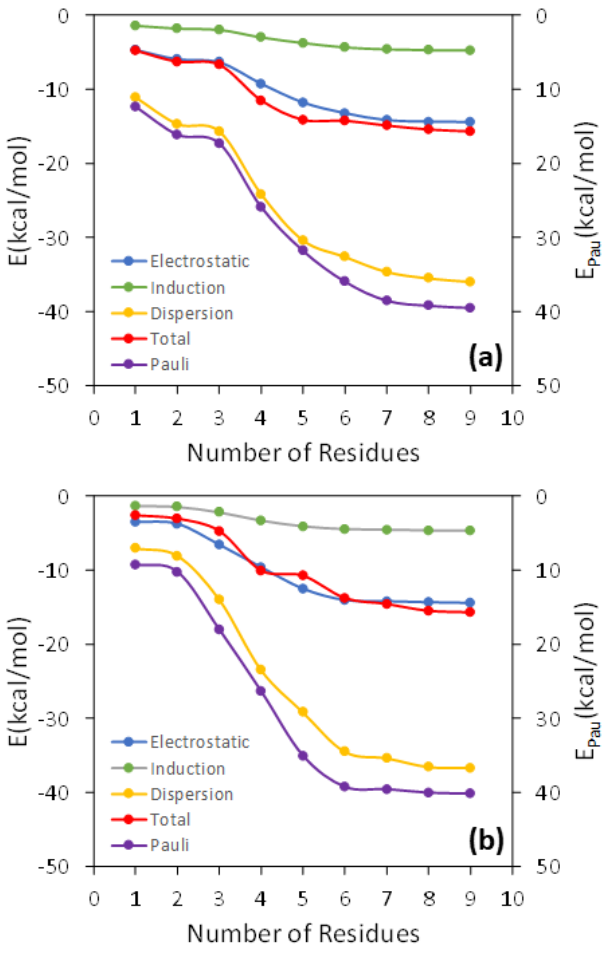
Figure 2. Analysis of the convergence of the interaction energy and its different components as the number of the DOPC molecules increases in the QM region for an arbitrary geometry around the free energy minima of the TCDD ( a ) and TCDF ( b ) permeation.